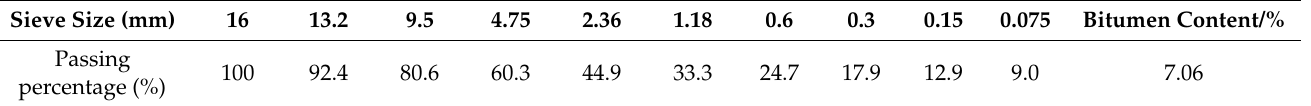
Table 2. Combined aggregate gradation of hydraulic asphalt concrete.